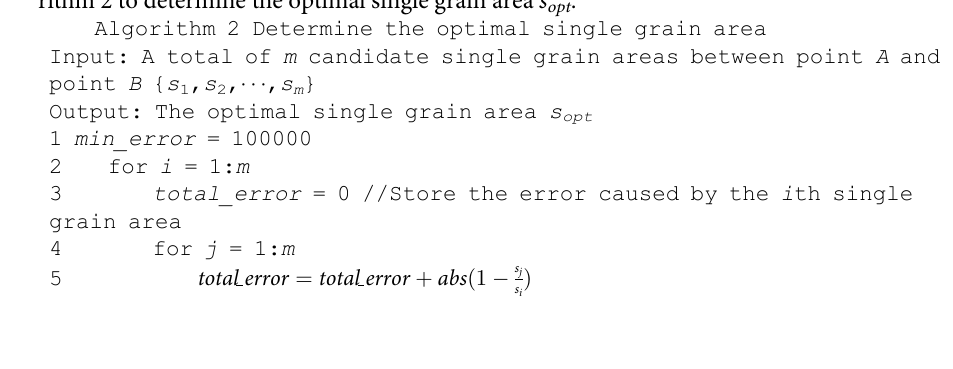
Algorithm 2 Determine the optimal single grain